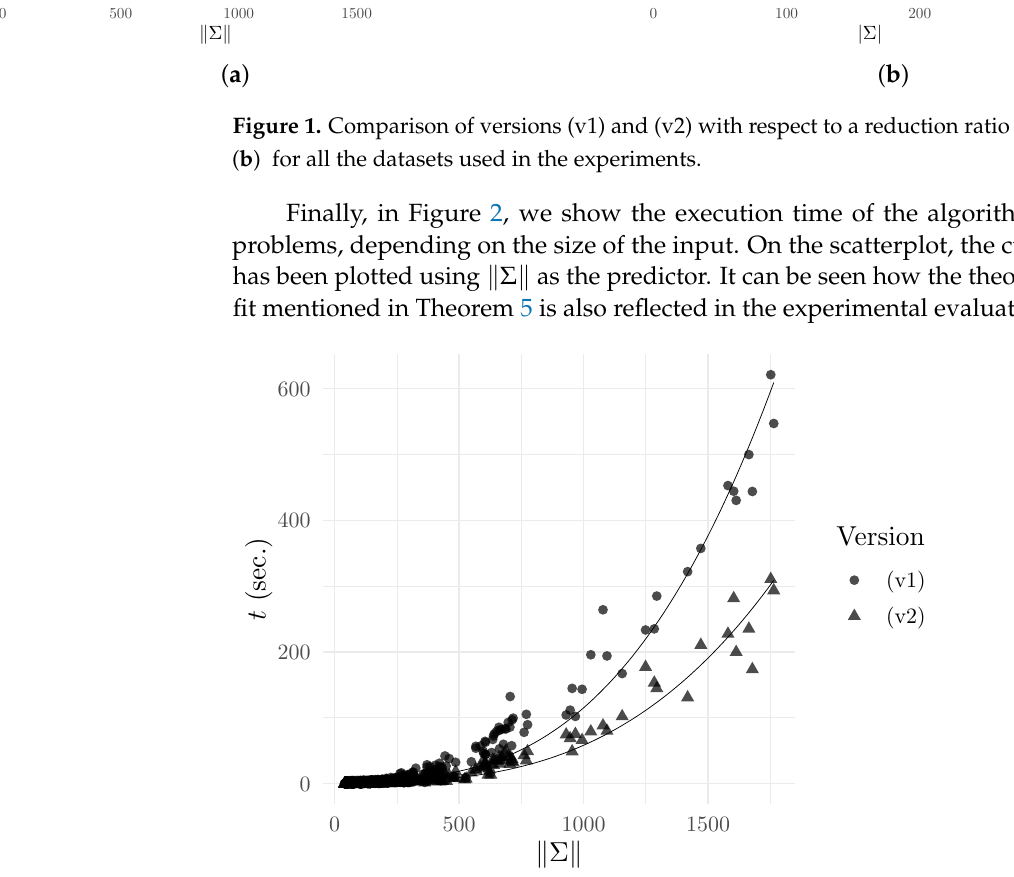
Σ Σ ( a ) and of (cid:107) (cid:107) | |